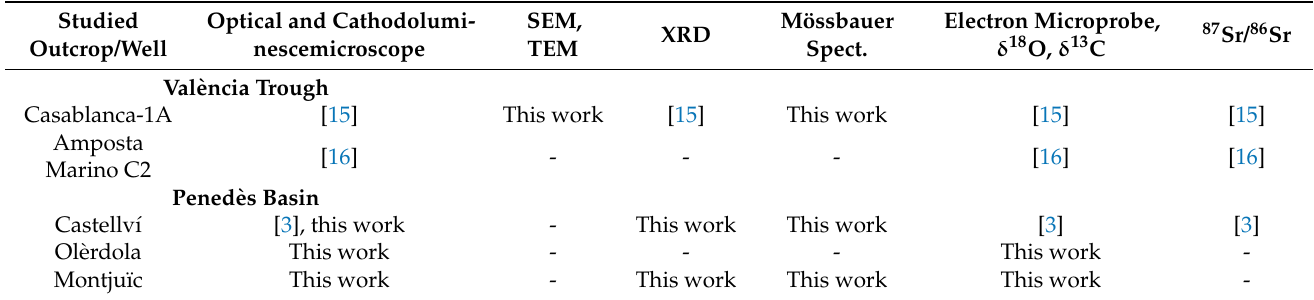
Table 1. List of analytical methods used in this work and the areas where they were applied. Data from this work and from previous authors are also